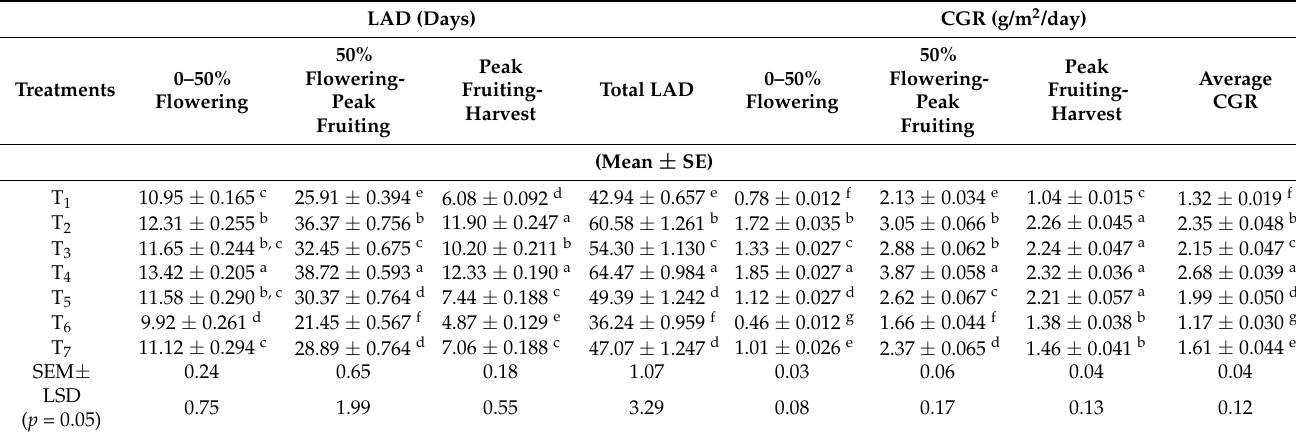
Table 4. Effect of elevated CO 2 and temperature on leaf area duration (LAD) and crop growth rate (CGR) of tomato at different growth